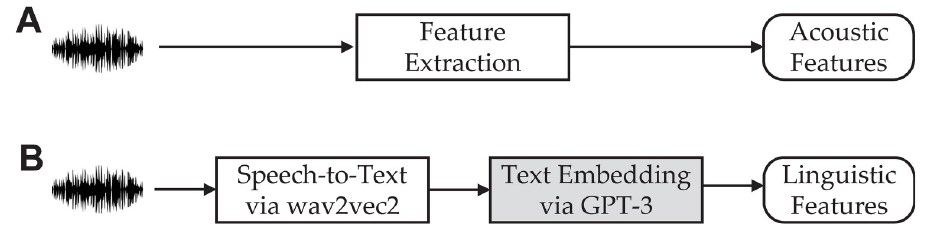
Fig 1. Schematic showing two different feature representations that are derived from speech. A. The acoustic features are engineered to capture the acoustic characteristics of speech and therefore the pathological speech behavior. B. The linguistic features, represented as text embeddings, are derived from the transcribed text. Central to our proposed approach is the GPT-3 based text embeddings (shaded), which entail meaningful vector representations that can capture lexical, syntactic, and semantic properties for dementia classification.